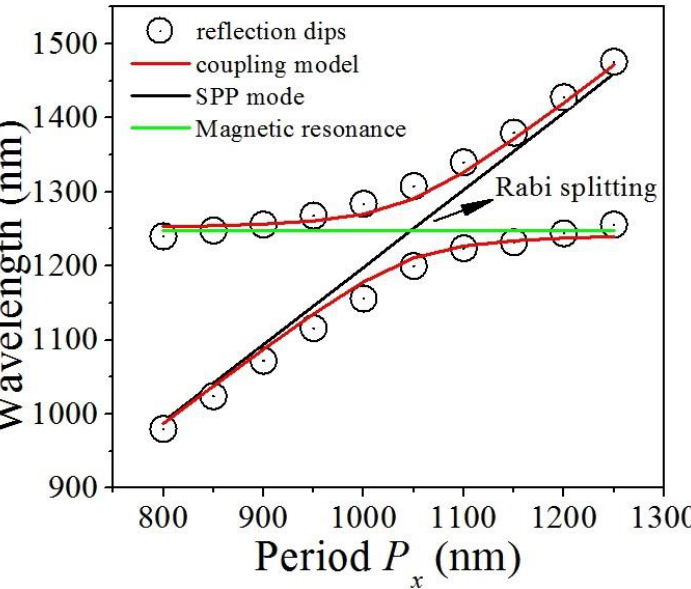
Figure 4. The positions of reflection dips (dip 2 and dip 3 in Figure 2) for different periods. The position (horizontal green line) of the magnetic resonance and the position (black diagonal line) of the SPPs are also shown.